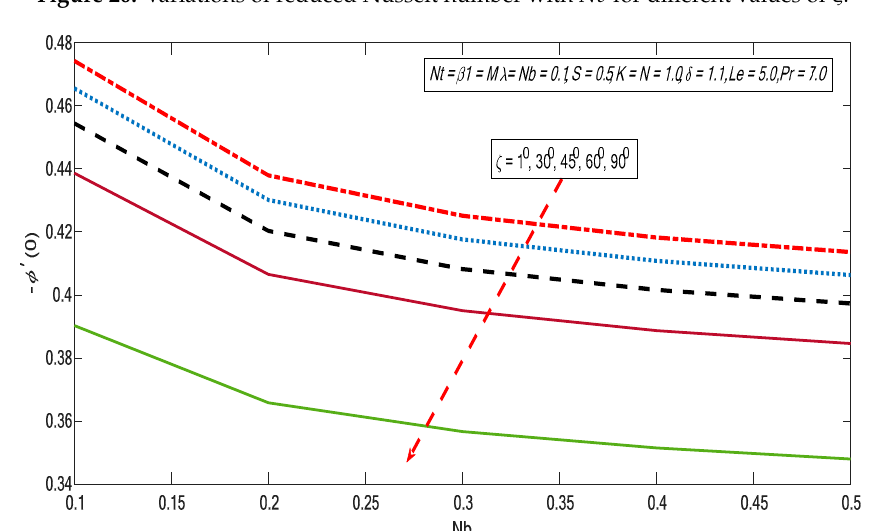
Figure 20. Variations of reduced Nusselt number with 𝑁𝑏 for different values of 𝜁 . Appl. Sci. 2019 , 9 , x FOR PEER REVIEW